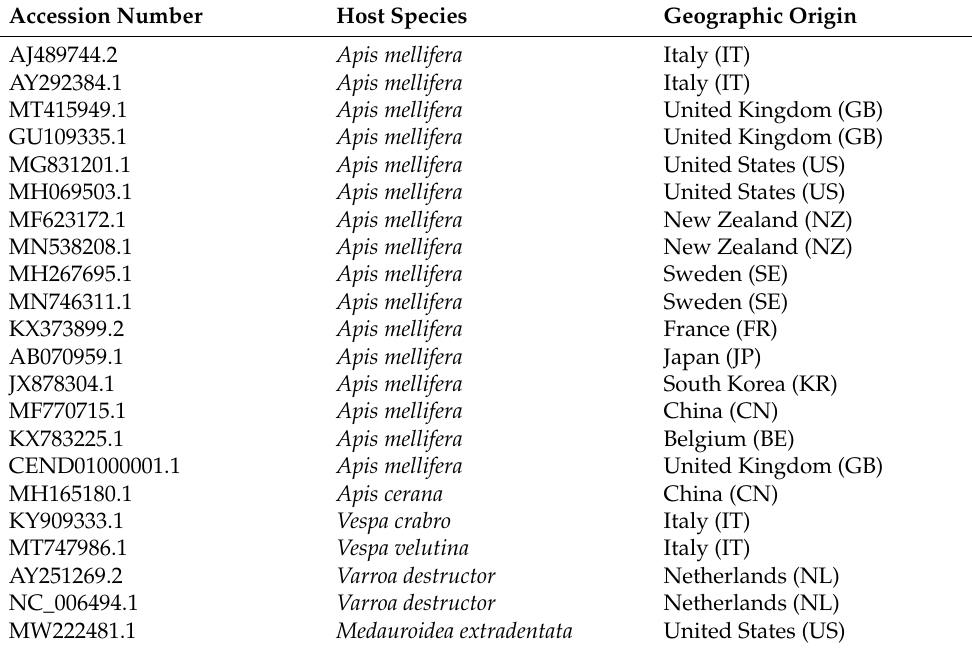
Table 2. DWV sequences published in GenBank used to construct phylogenetic